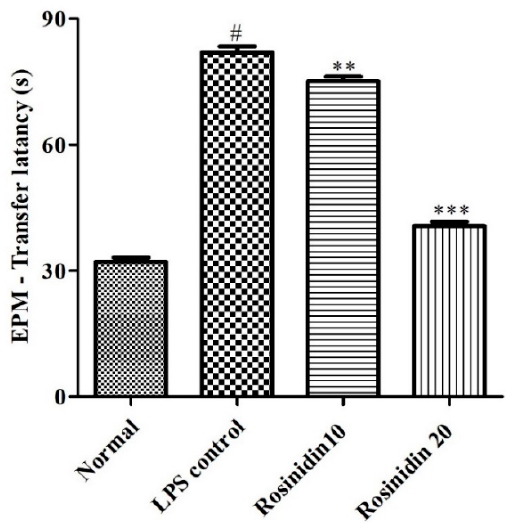
Figure 4. Effect of rosinidin on memory and learning abilities of animals estimated using EPM test on LPS-treated rats. Values are expressed in mean ± S.E.M. (n = 6). # p < 0.05 vs. normal control rats and ** p < 0.01; and *** p < 0.001 vs. LPS control rats. One-way ANOVA followed by Tukey’s post hoc test.